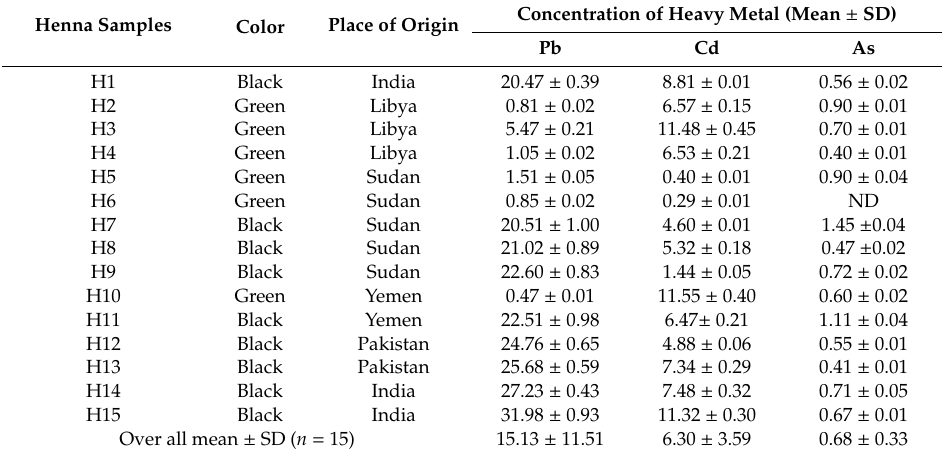
Table 6. Concentration levels of heavy metals ( µ g · g − 1 ) in the investigated henna samples. Henna Samples